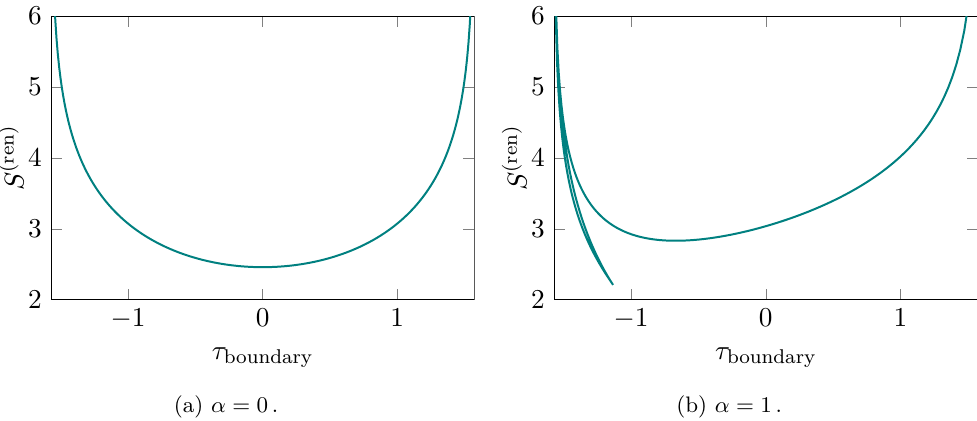
Figure 7 . Renormalized entropy S (ren) associated to extremal surfaces connecting to the brane. In both plots y brane = 1 . 4 . (a) shows the situation for α = 0 . (b) For α = 1 , we see that at early times − there are three candidate surfaces. Of these, the surfaces which connect to the brane at much earlier times give the smallest entropy. Those surfaces are not available anymore after τ boundary and therefore the area of the smallest connected extremal surface exhibits a discontinuous